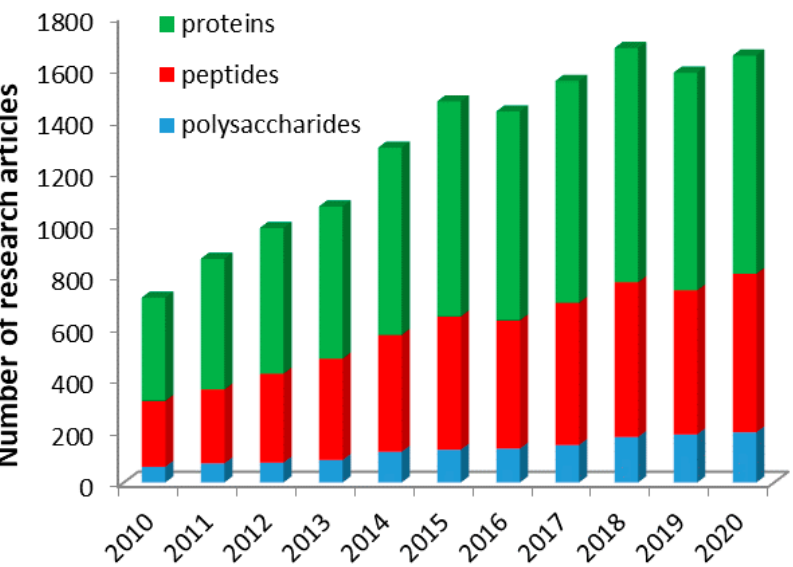
Figure 2. Number of research articles, from the last decade, given by Scopus using a combination of three keywords, such as: micelle, polysaccharide or peptides or proteins, and drug delivery system.